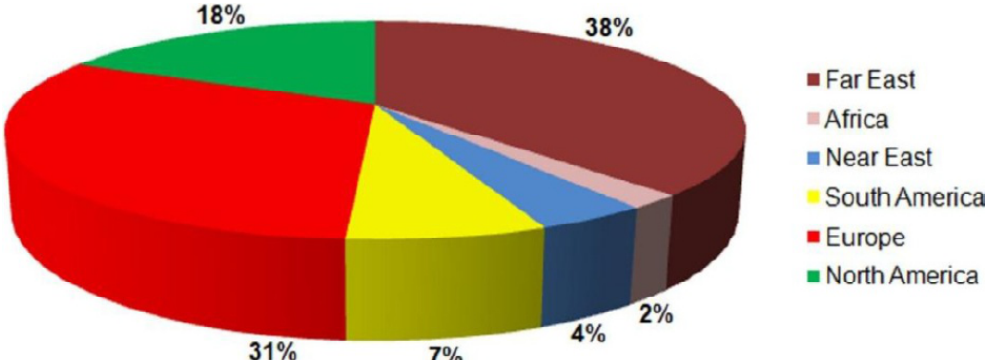
Fig. 10. Worldwide consumption of zinc oxide, reprinted with permission (open access) of Ref [63], Copy- right 2014 MDPI.